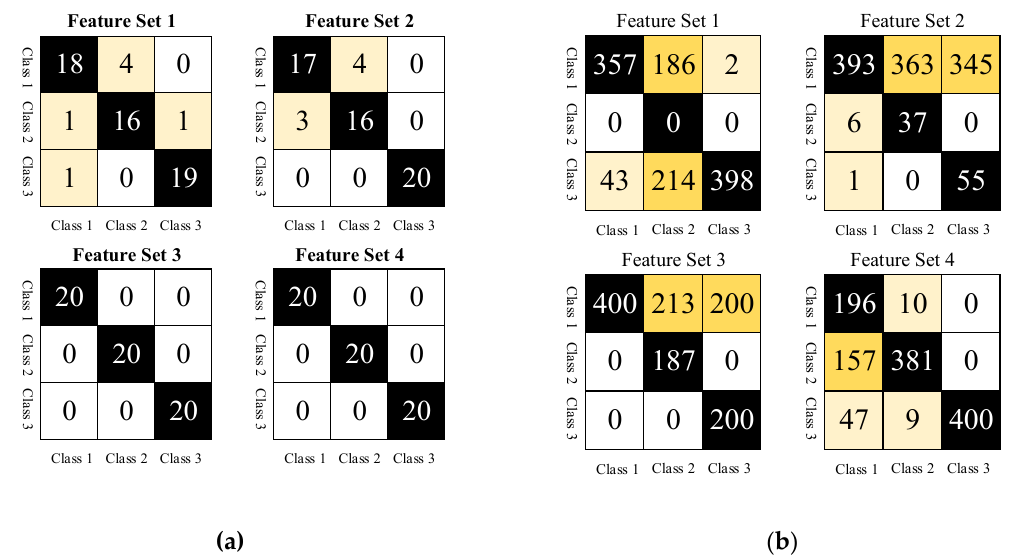
Figure 8. Prediction results for the internal and external test sets with the diagnosis model based on 500 A current data set: ( a ) internal testing; ( b ) external testing.